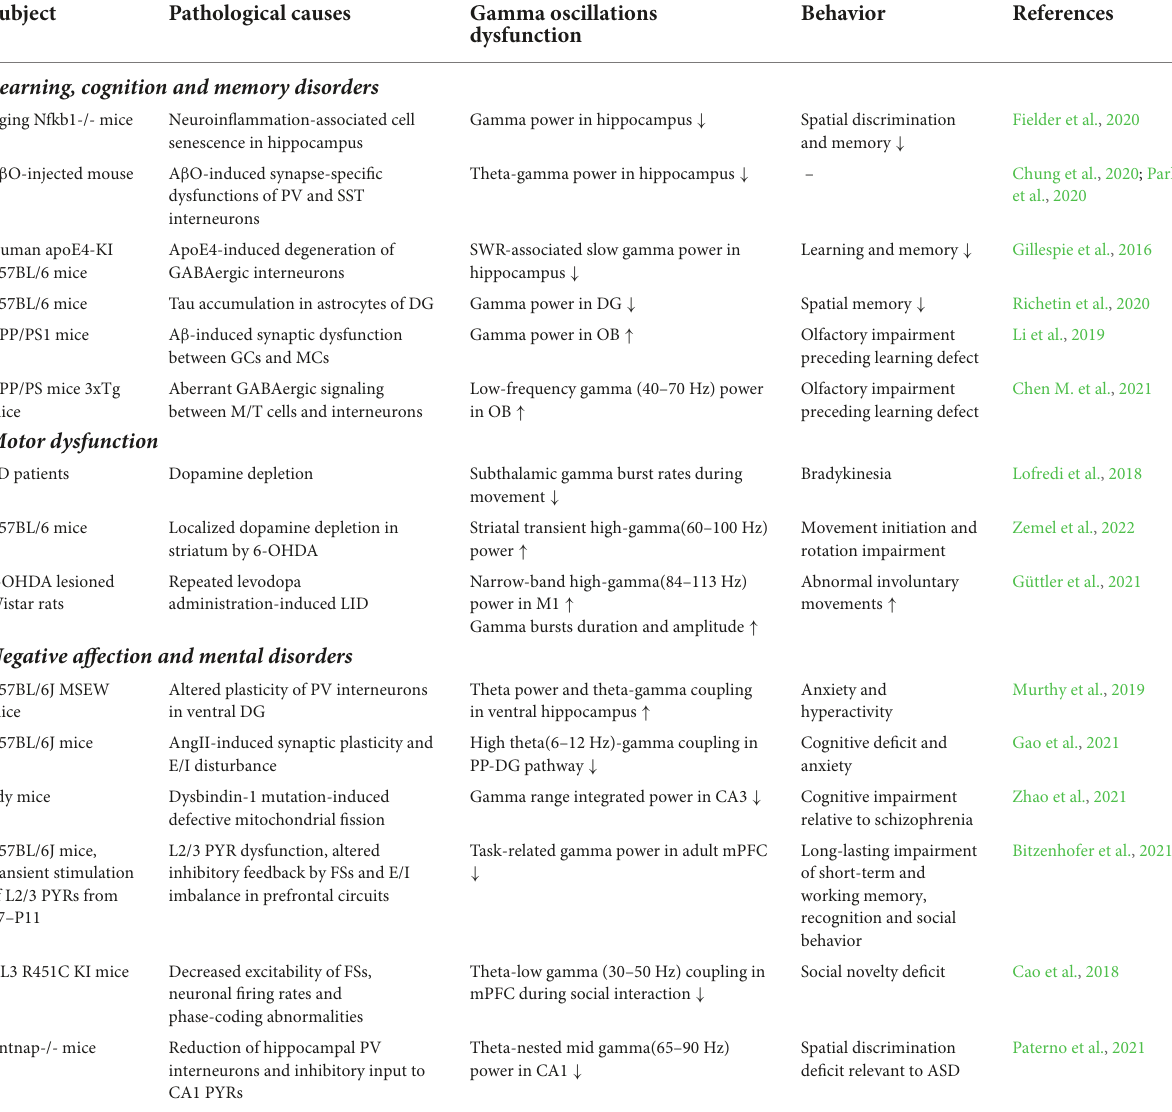
TABLE 1 Abnormal gamma oscillations in CNS